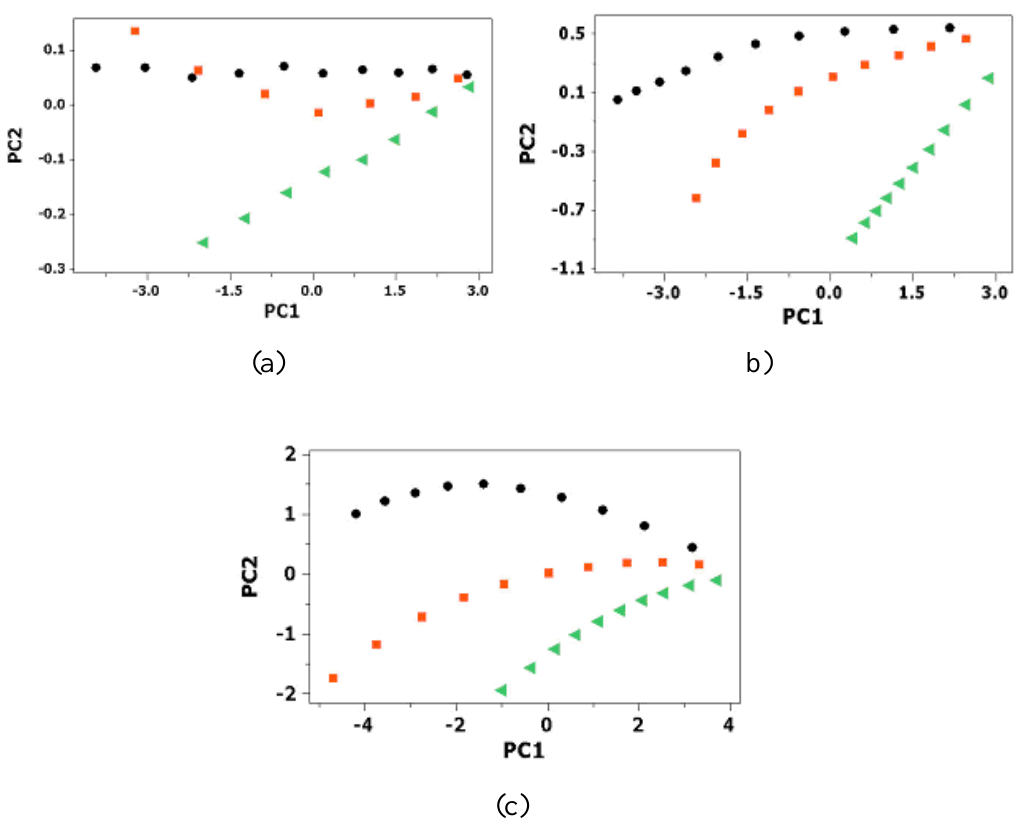
Figure 4 . PCA score plots in the PC1-PC2 plane for sensor arrays based on MUA-Au Au (b), and hybrid of MUA-Au nm